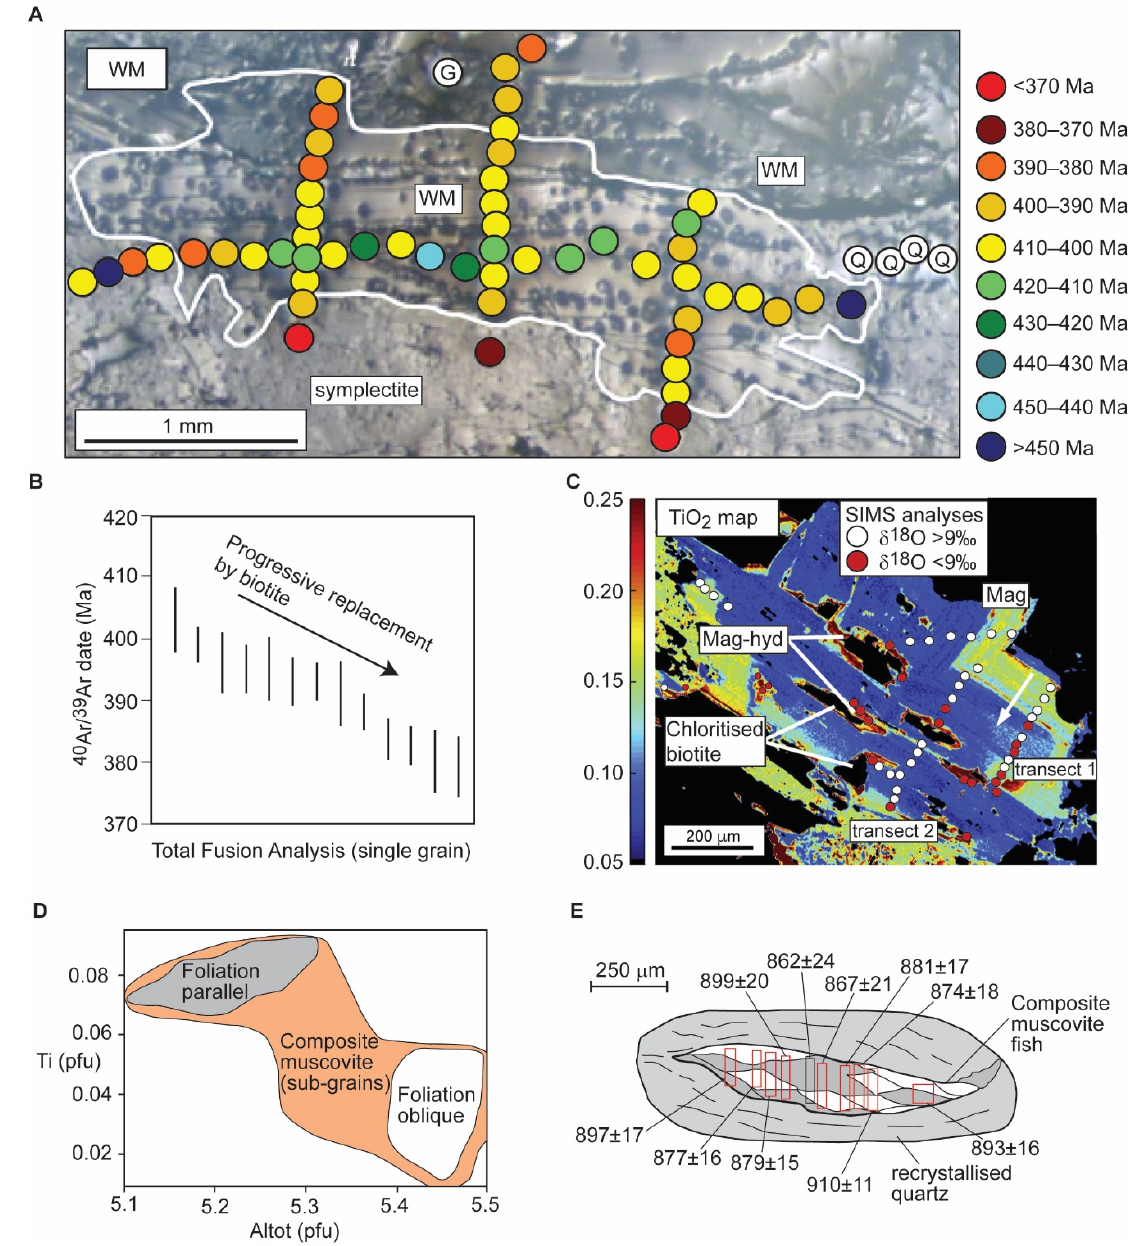
Figure 6. ( A ) In situ 40 Ar/ 39 Ar dates in white mica in medium grained, unfoliated gneisses, Western Gneiss Complex, Norway [3]. The white mica has been partially replaced at the rims by biotite-plagioclase symplectites. The dates reveal patchy date distributions with no clear core-rim profiles, which would be predicted by volume diffusion with a fully open boundary. Diffusion has not been the sole mechanism that redistributed Ar, despite cooling from temperatures (~700 °C) well above the closure temperature. Rather, Ar distribution was dominated by white mica breakdown to biotite ( B ), and the introduction of extraneous Ar from a semi-closed grain boundary network. G: Garnet, Q: Quartz, WM: White Mica. Data and interpretation are from McDonald et al. (2016) [3]. ( C ) Microscale d 18 O and chemical variability of muscovite within monzogranite from the Larderello-Travale Geothermal Field (Italy), with a medium grained, typical igneous texture with primary magmatic white mica (mag) that is partially chloritised, hydrothermal white mica (mag-hyd) and late stage sericite (data and images are from [57]). ( D ) Ti and Al compositions of low-Al, foliation parallel (grey) and high-Al, foliation oblique (white) muscovite crystals from the Porsgrunn-Kristiansand Shear Zone, southern Norway [1]. The orange field shows the range of compositions obtained from composite muscovite fish (shown in ( E )) that cover the entire compositional range, and also yield the largest range in in situ 40 Ar/ 39 Ar dates. Red rectangles show the region of in situ ablations, and white and dark fields are the same as those shown in ( D ).